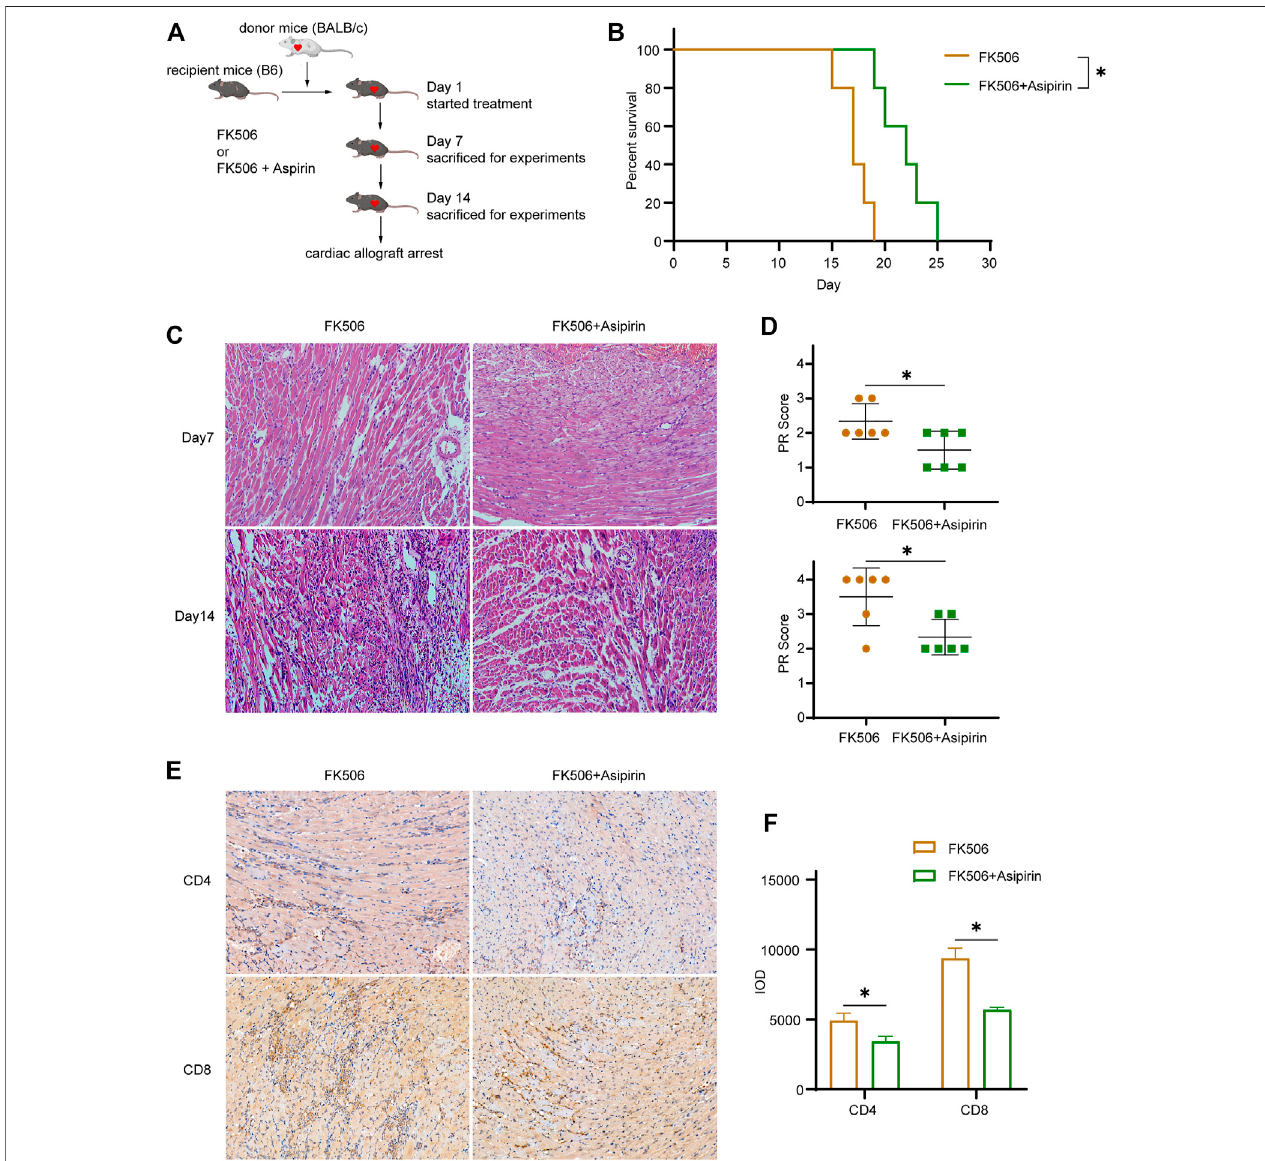
FIGURE 6 | Aspirin combines with calcineurin inhibitor further antagonizes cardiac allograft rejection, establishing the model of allogeneic heart transplantation. Fromthe fi rstdayaftersurgery,FK506(1 mg/kg/d)orFK506(1 mg/kg/d)+aspirin(200 mg/kg/day)withanintraperitonealinjectionwasadministered. (A) Theschematic oftreatment and experiment protocolsfollowinghearttransplantation. (B) ThecombinationofFK506and aspirin treatment signi fi cantlyprolongedthesurvivalofcardiac allograft(MST,21.8 ± 1.1versus17.2 ± 0.7 days, n (cid:2) 5pergroup, p < 0.05). (C) Cardiacallograftswereharvestedon7thandthe14thdayaftertransplantation;the allograft sections weremade, and hematoxylin – eosinstainingwereperformed( × 40, n (cid:2) 6per group). Thein fi ltration ofin fl ammatorycellsand thenecrosisofmyocardial cellsinallograftwerefurtherinhibitedintheFK506+aspirin-treatedgroupcomparedwiththeFK506-treatedgroup. (D) ThePRscorewasperformedontissuesections of each group on the 7th and the 14th day after transplantation ( n (cid:2) 6 per group). (E ) Cardiac allografts were harvested on the 14th day after transplantation, the tissue sections were made, and immunohistochemical staining of CD4(+) and CD8(+) T cells was performed ( × 40, n (cid:2) 6 per group). Compared with the FK506-treated group, the in fi ltration of CD4(+) and CD8(+) T cells in allografts was signi fi cantly reduced with the FK506 + aspirin treatment. (F) IOD was used to analyze the amount of CD4(+) and CD8(+) T cell in fi ltration in the allografts in each group ( n (cid:2) 6 per group). * p < 0.05; MST, mean survival time; IOD, integrated optical density.